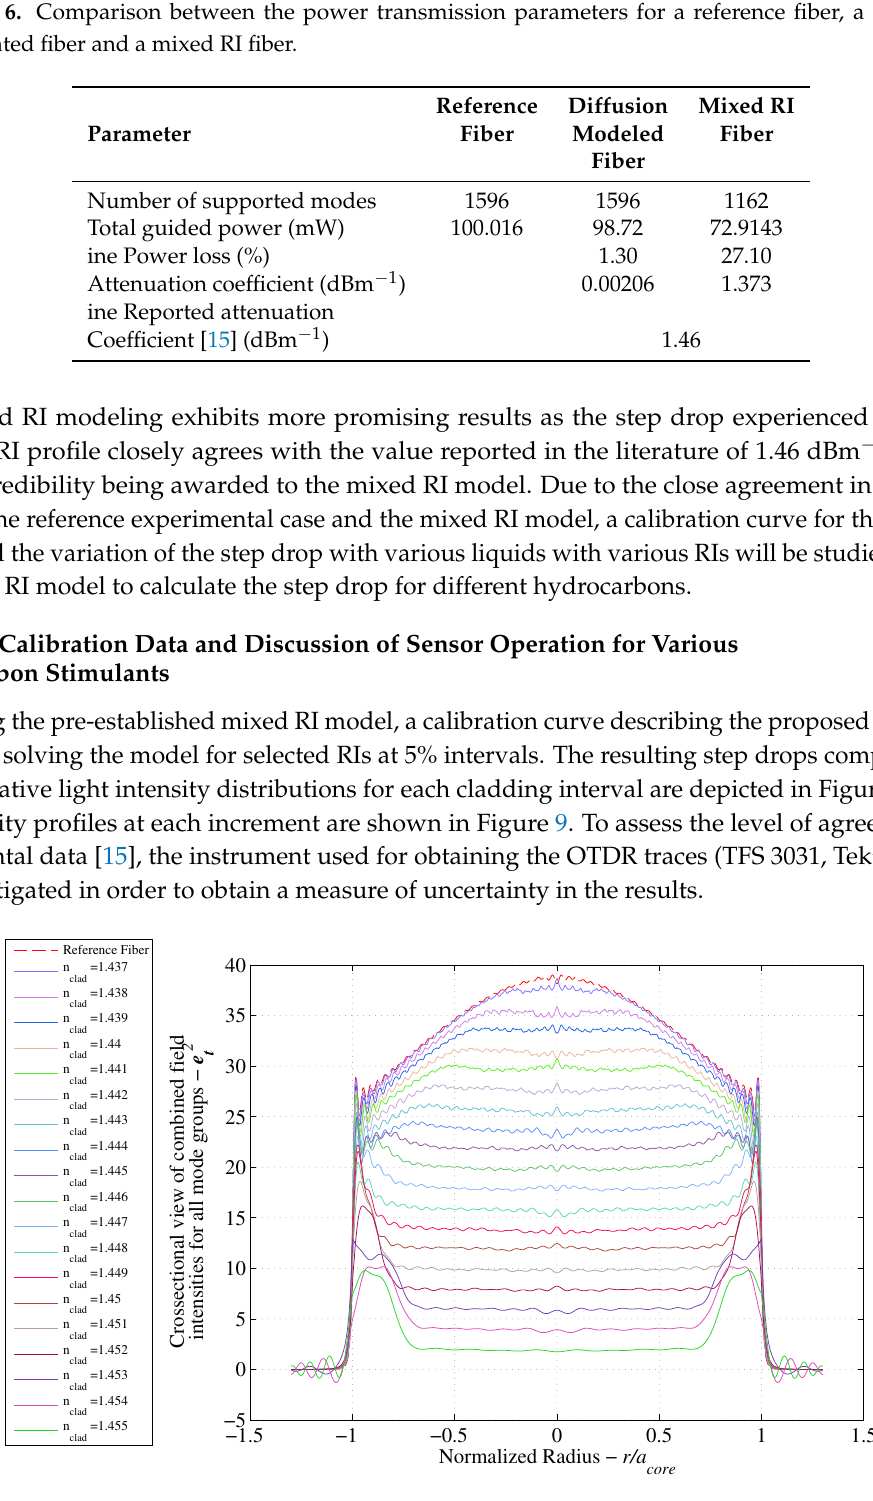
Figure 9. Cumulative intensity of selected cladding